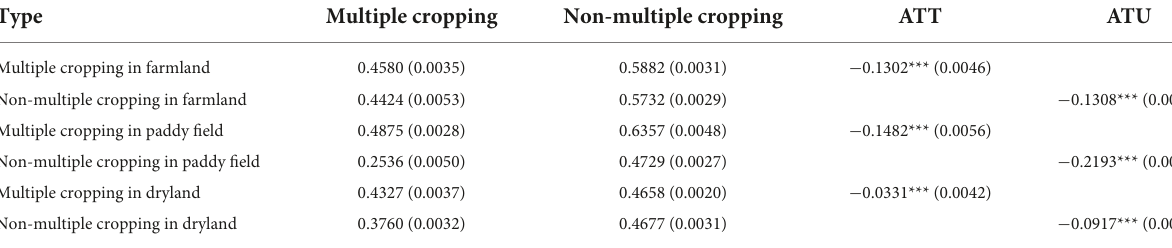
TABLE 4 The average treatment effect of multiple cropping of various types of farmland on relative poverty.